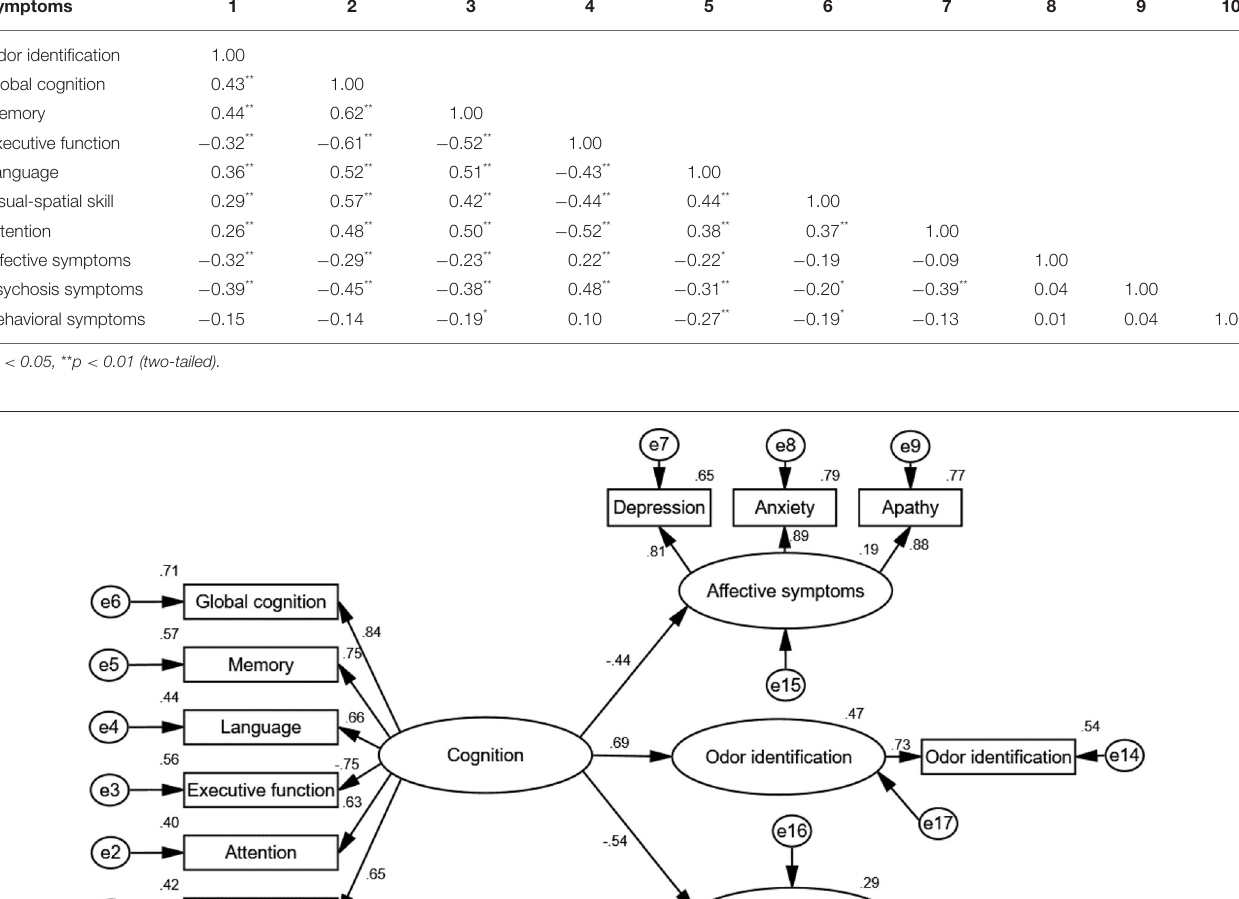
TABLE 3 | Correlation between cognition, NPS, and odor identification in patients with NPS ( N = 168). Symptoms